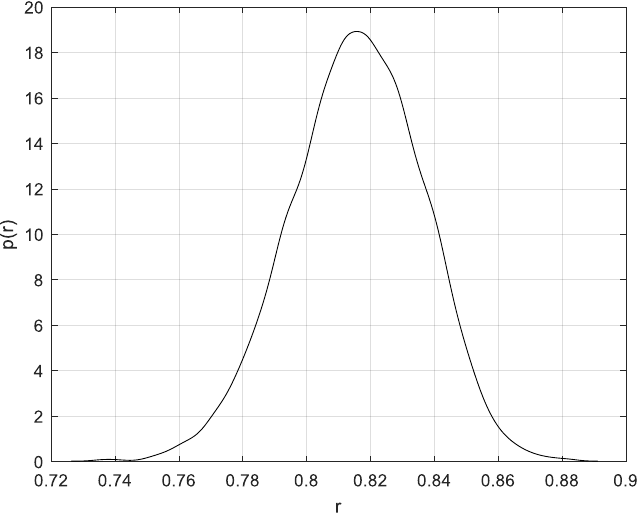
Figure 5. Prior PDF of R as smoothed kernel estimator for case C11.